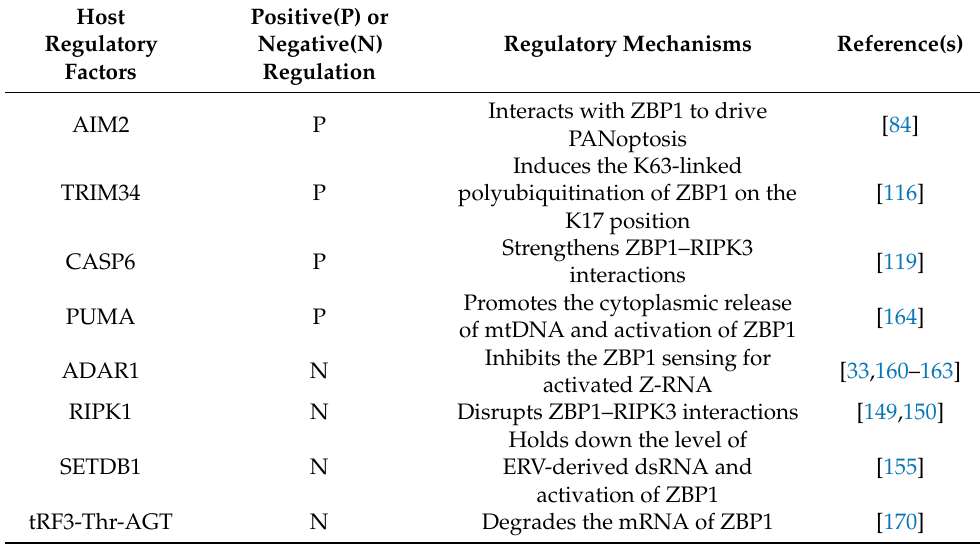
Table 2. The host proteins regulating the ZBP1